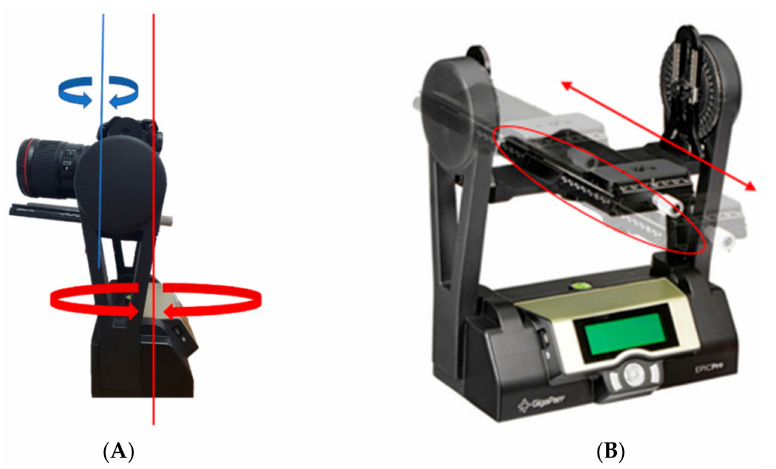
Figure 3. Panoramic instrument of GigaPan EPIC Pro V. ( A ) Eccentric issue caused by different axes of rotation between panoramic instrument (red part) and camera (blue part); ( B ) Adjustable position (scale marks) to put camera (red